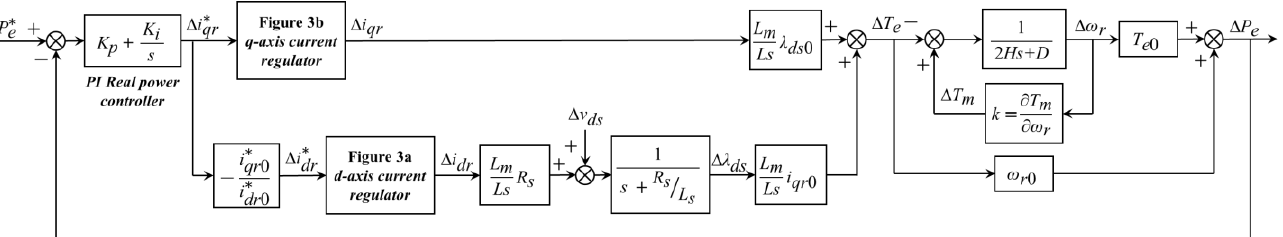
Figure 5. Block diagram of complete linearized model for DFIG real power controller.